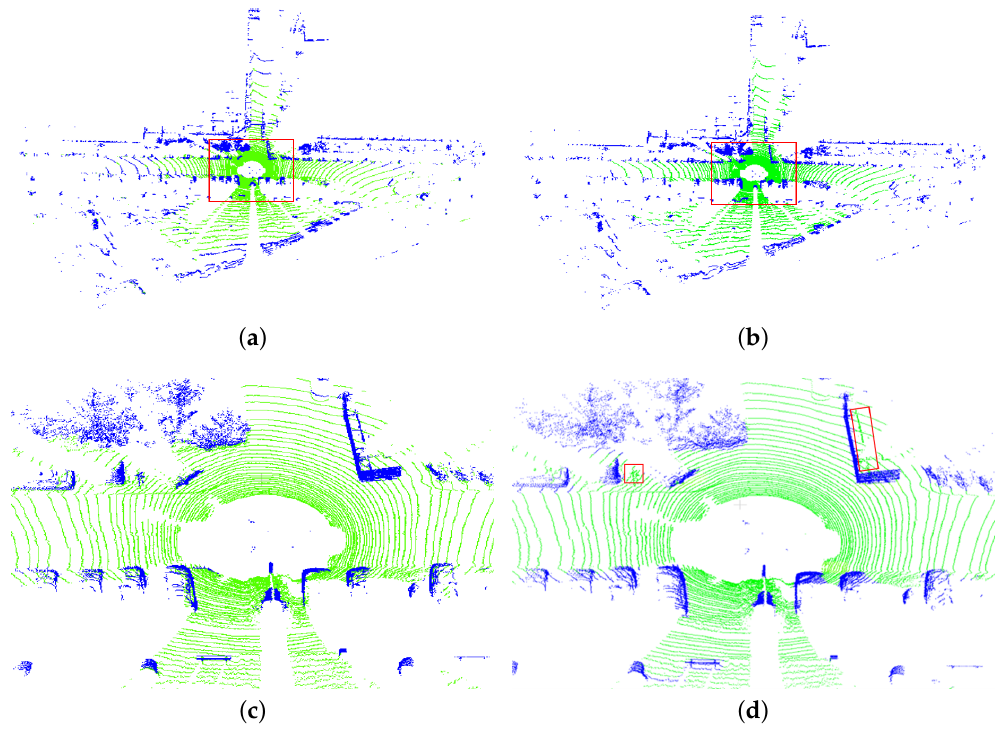
Figure 5. The result of the proposed method. The red box area in ( d ) is classified incorrectly. ( a ) The point cloud manually labeled. ( b ) The point cloud processed by the proposed method. ( c ) The red box area in ( a ). ( d ) The red box area in ( b